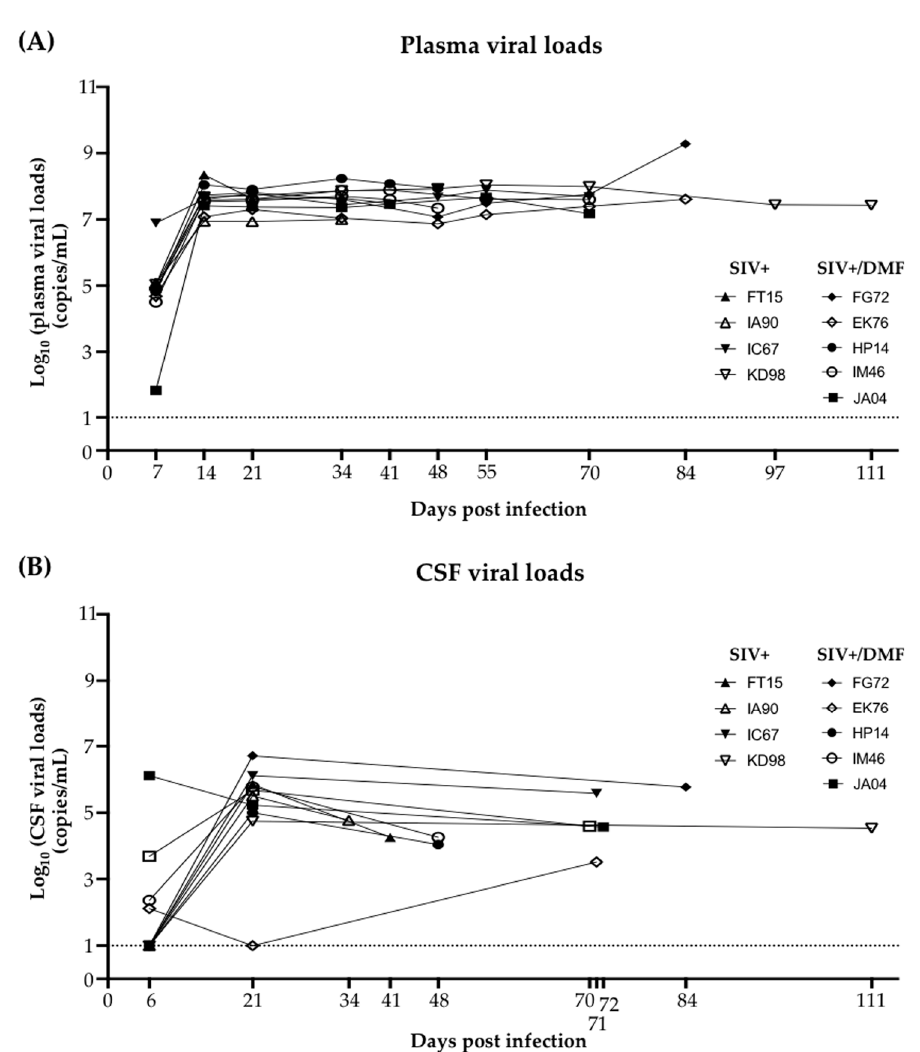
Figure 3. SIV RNA was detectable in plasma from all animals after 7 dpi and in cerebrospinal fluid (CSF) at the necropsy time points. ( A ) SIV plasma viral loads (RNA copies/mL) from each animal. SIV RNA was detectable from 7 dpi until the necropsy day. ( B ) The SIV CSF viral loads (RNA copies/mL) from each animal. SIV RNA was detectable in one animal at 6 dpi. One animal did not have detectable CSF SIV RNA until the necropsy day. Nine rhesus macaques, all SIV-infected, were used in the study (4 untreated animals and 5 DMF-treated (90 mg total DMF daily)). Each dot represents the value for each animal at each time point. Individual animals are listed by unique letter–number combinations.